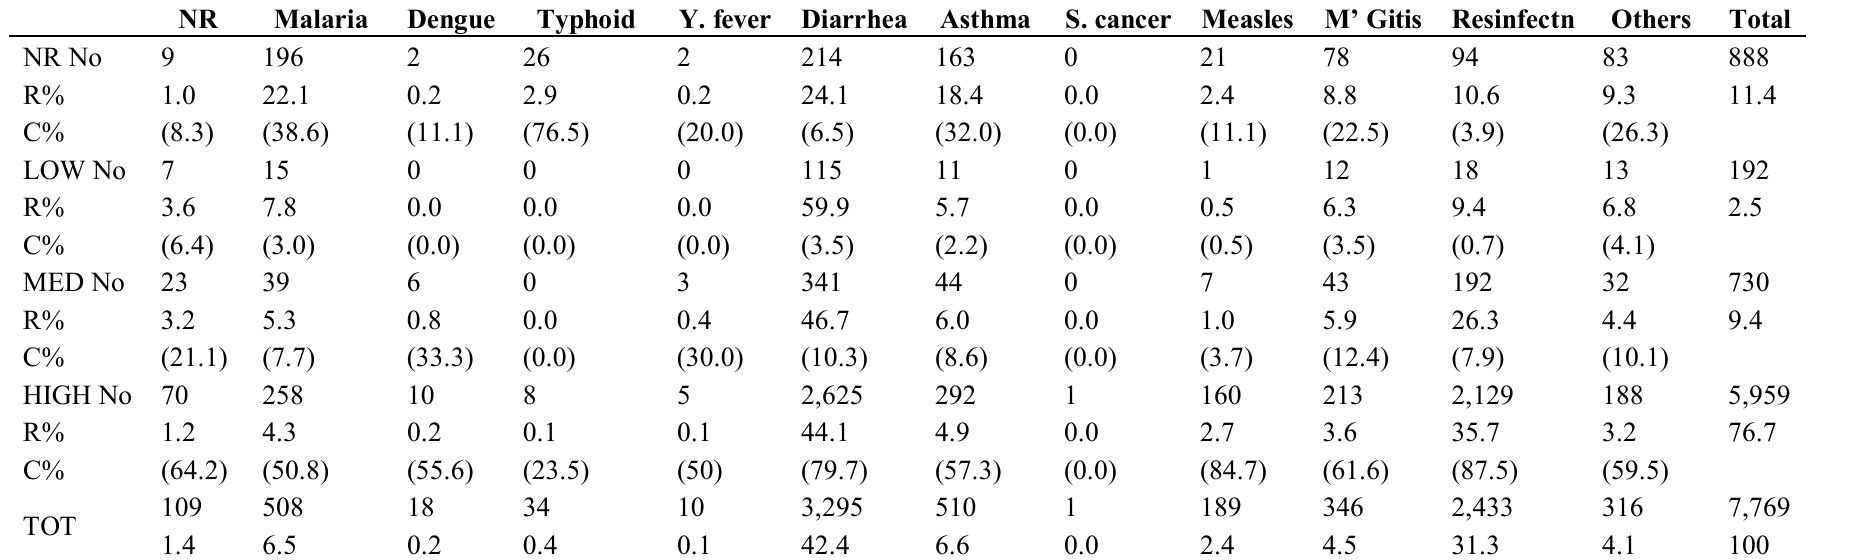
Table 2. Incidence of disease by residential